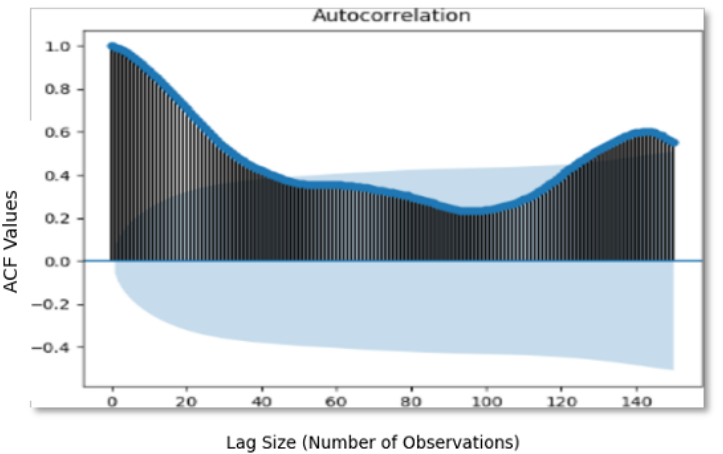
Figure 2. Autocorrelation plot for Trento data . The vertical axis shows the ACF value. The horizontal axis of the plot shows the size of the lag between the elements of the time series.